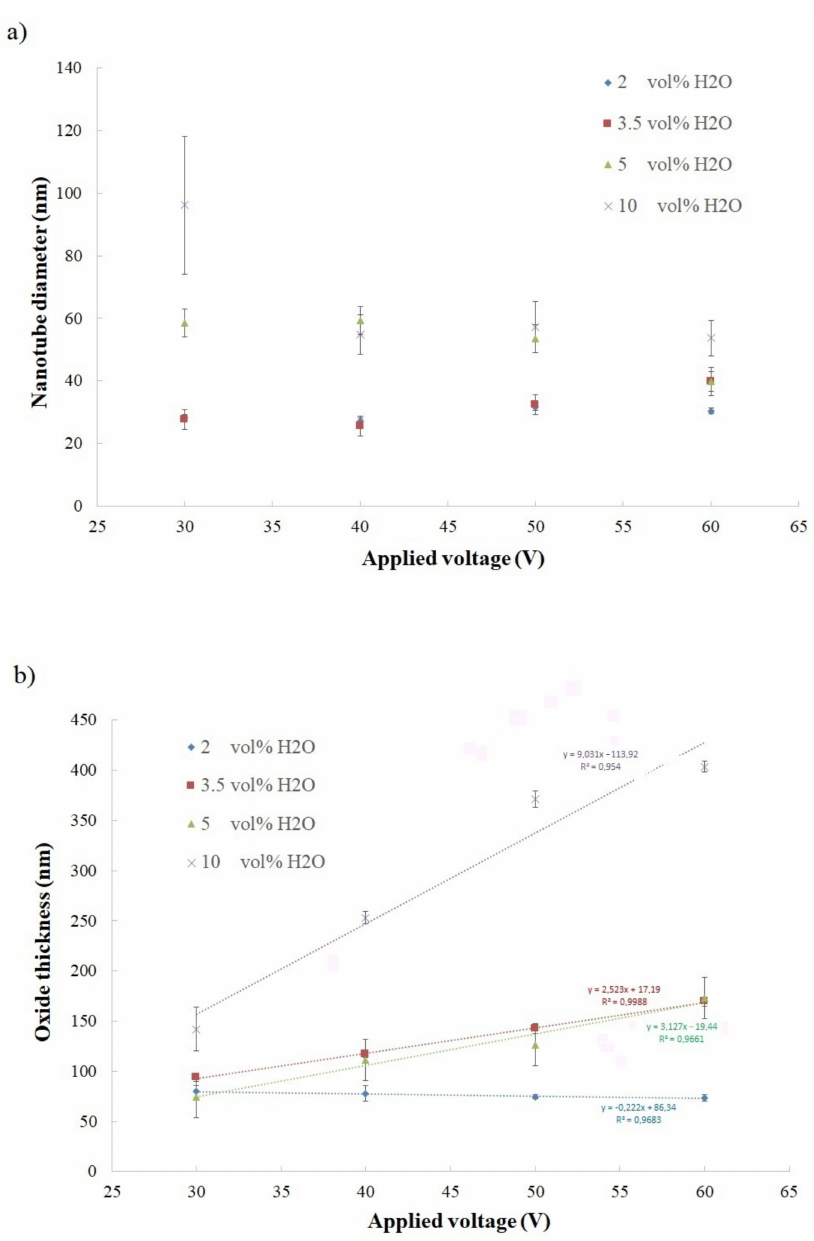
Figure 5. Nanotubes diameter in the function of applied voltage ( a ) and anodic titanium oxide thickness in the function of anodizing voltage ( b